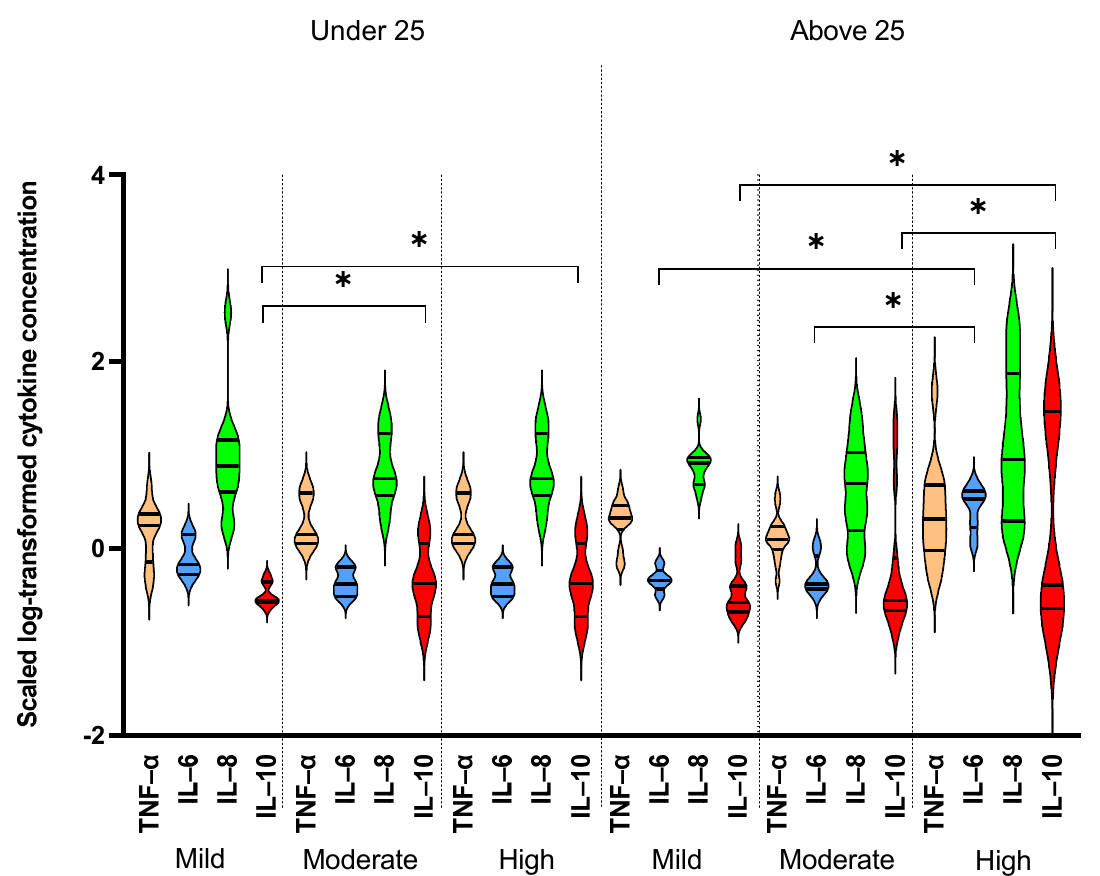
Figure 3. Comparing levels of serum cytokines between age and sport intensity groups. TNF- α , IL-6, IL-8 and IL-10 were compared between younger (less than 25 years old, n = 45) and older (more than 25 years old, n = 35) elite athletes in different sport intensities (low, n = 18, moderate, n = 31 and high, n = 31). Linear regression model was used to compare cytokine levels in different age and sport intensity groups taking gender and in/out of competition status as potential confounders. Data are presented as median and IQR. * p <0.05.